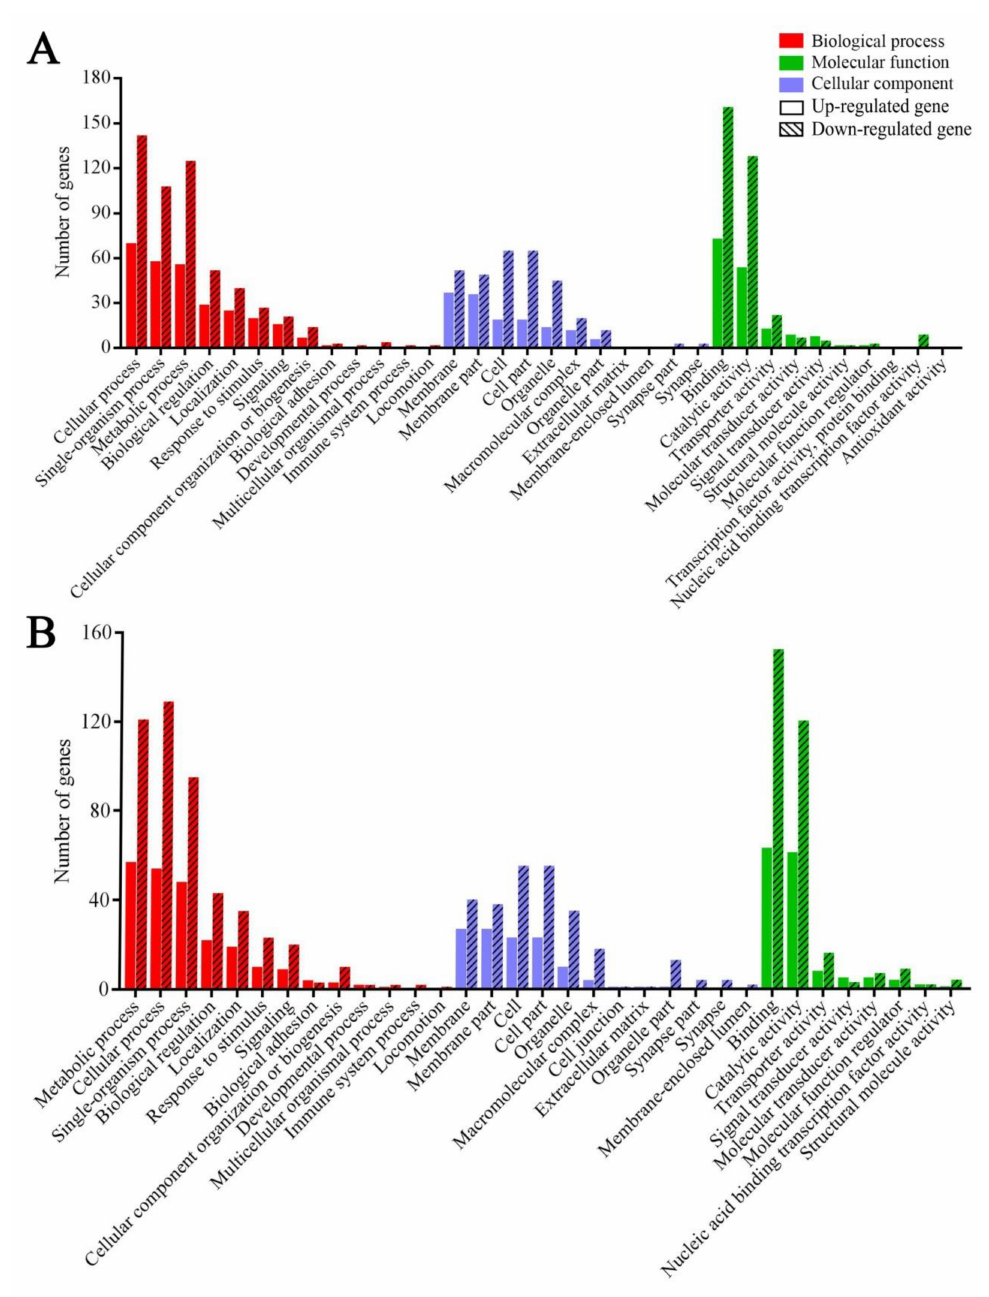
Figure 4. GO classification of DEGs in A. c. cerana workers’ midguts at 7 dpi ( A ) and 10 dpi ( B ) with N. ceranae